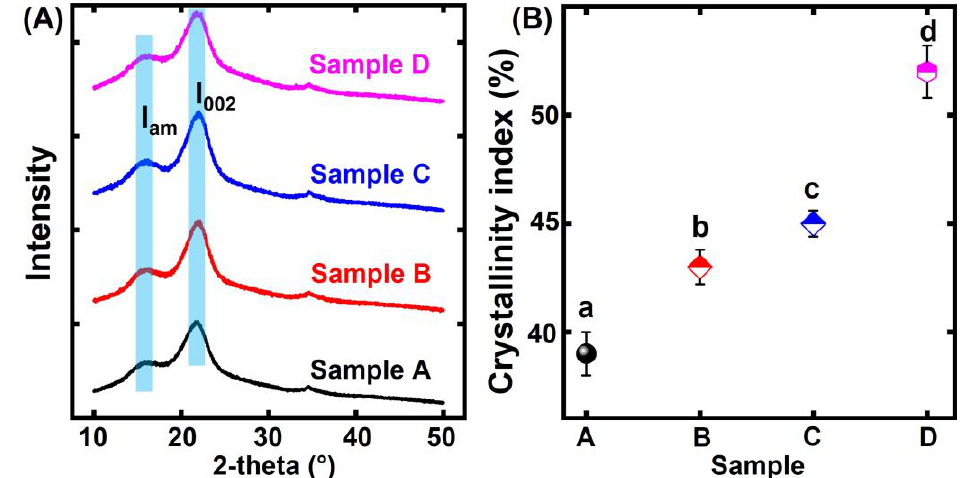
Figure 2. XRD spectra of moso bamboo: ( A ) related XRD curves of different bamboo specimens; ( B ) crystallinity index of different bamboo specimens. Different significant differences between different groups ( p < 0.05). The error bar in the picture represents the standard